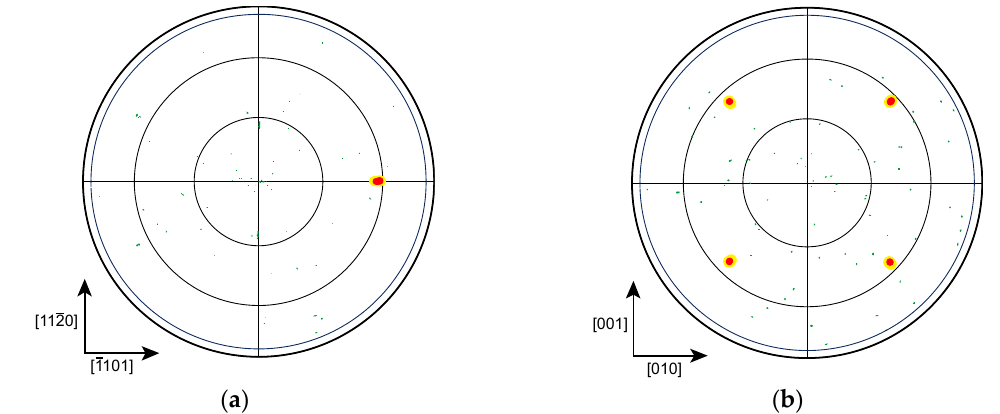
Figure 1. Typical X-ray pole figure pattern of the scandium nitride (ScN) films grown on the α -Al 2 O 3 (11 (cid:3364) 02) substrates: ( a ) (0006) diffraction of α -Al 2 O 3 (11 (cid:3364) 02) and ( b ) (222) diffraction of ScN.